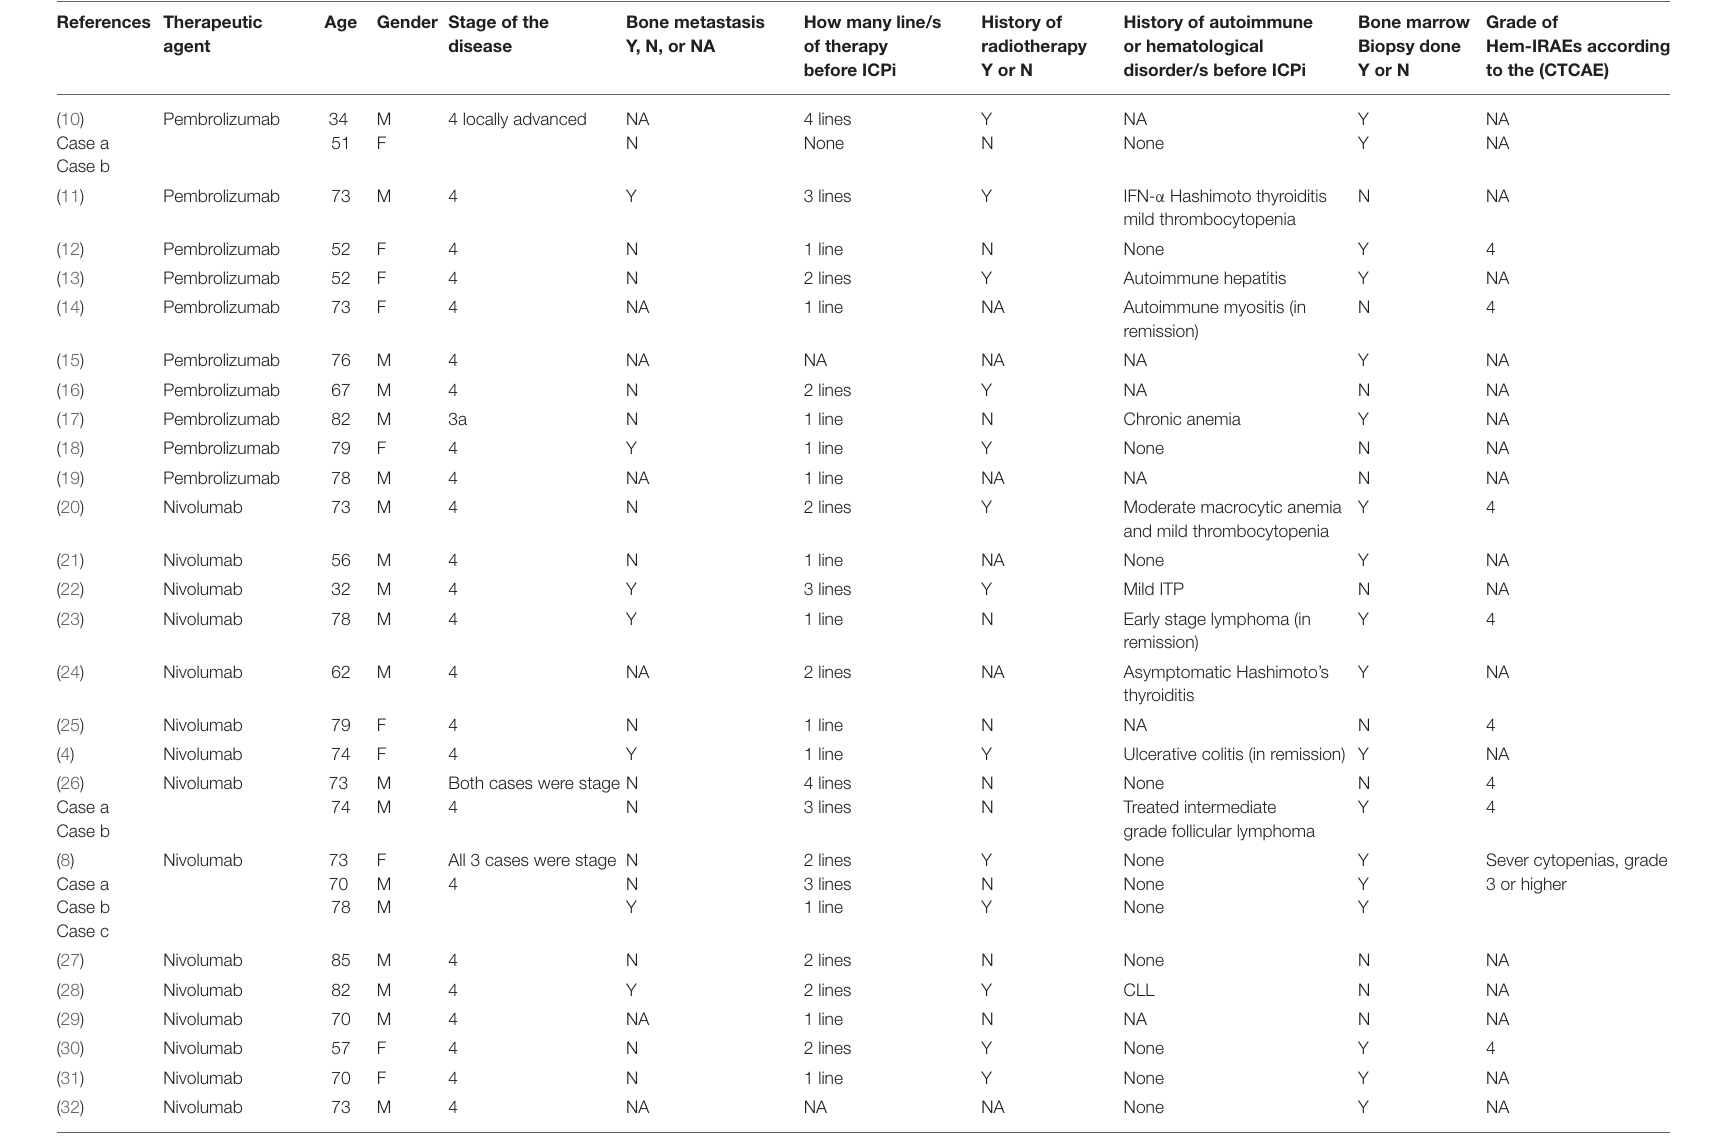
TABLE 3 | Characteristics of the described patients in the eligible case